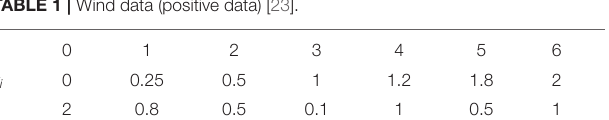
TABLE 3 | Positive data from Butt and Brodlie [25].